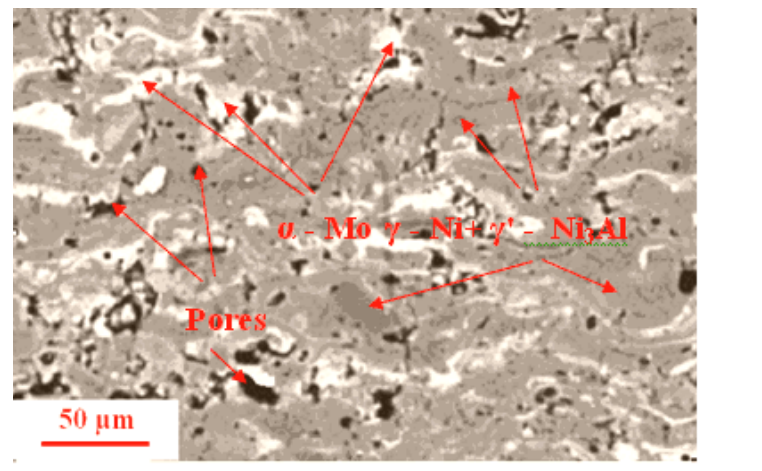
Figure 5 – (OM) Microstructure of the Ni5,5wt.%Al5 wt.%Mo coating deposited with a powder feed rate of 30